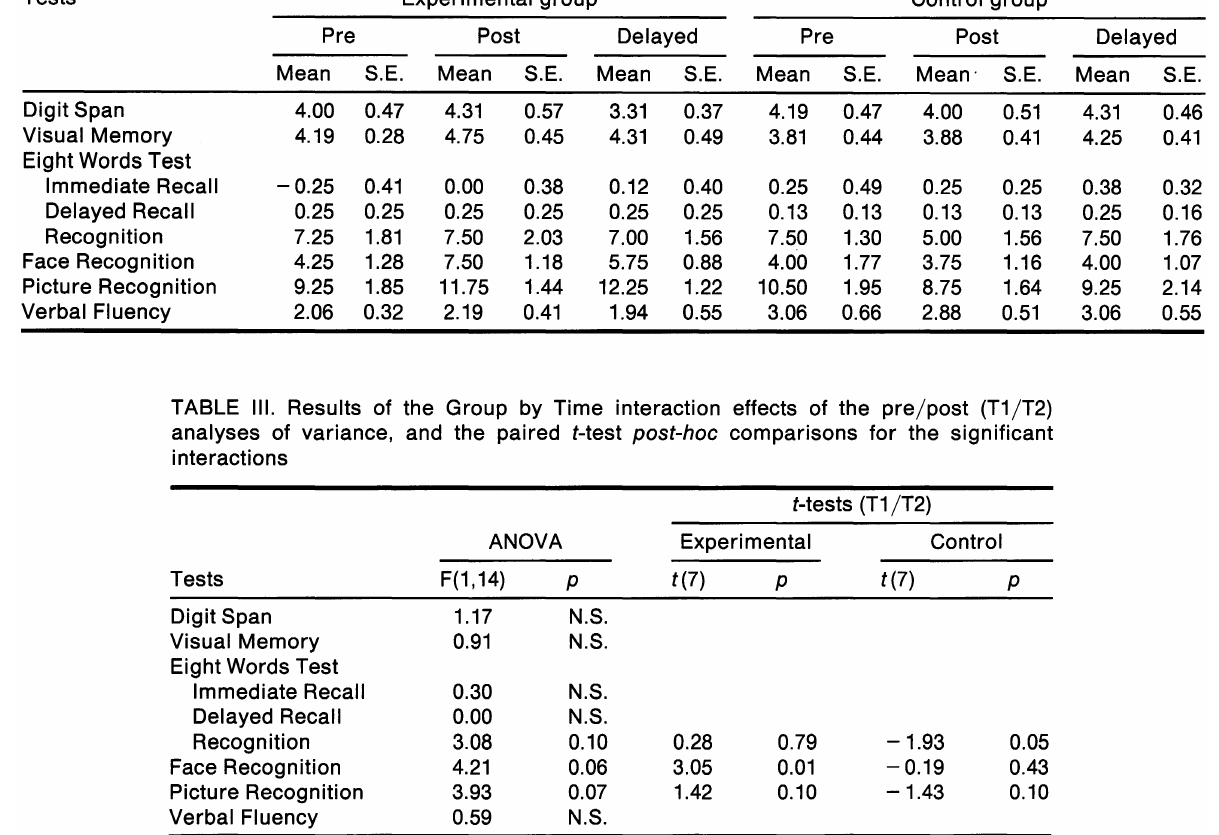
TABLE II. Means and standard errors of the mean of the neuropsychological tests Tests